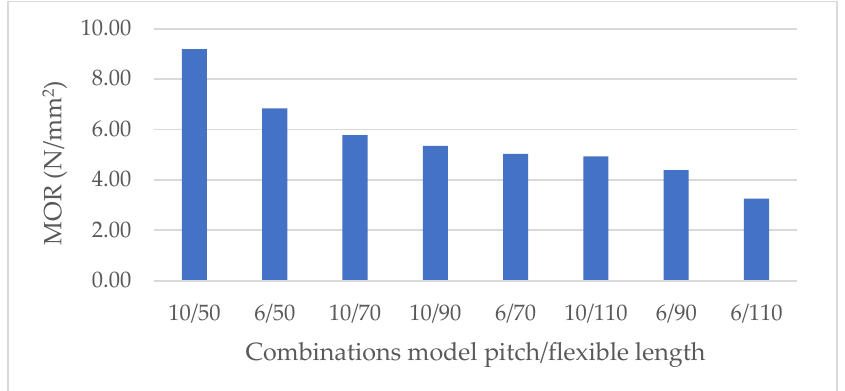
Figure 9. Mean values of the MOR for combinations of model pitch and flexible length.